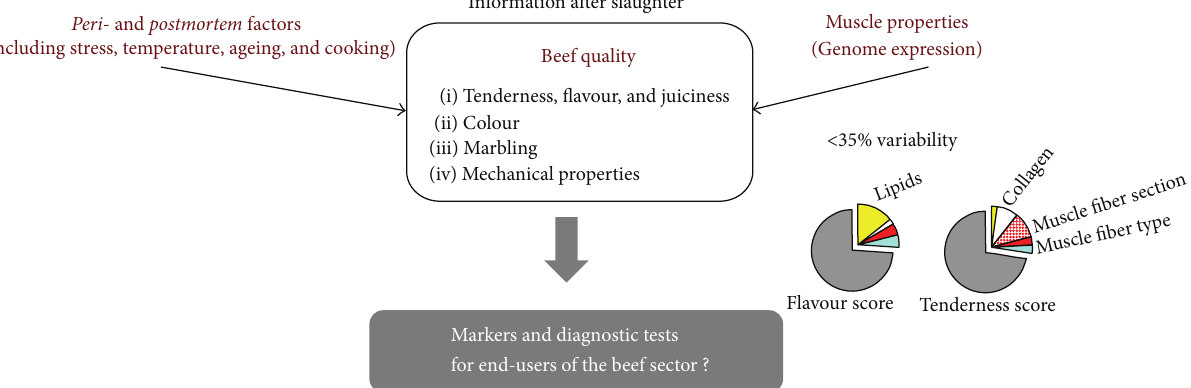
Figure 1: Beef sensory quality. A complex phenotypic trait that is expressed postmortem . A combination of molecular processes in the muscle both in the live animal and during the peri - and postmortem period (stress, interaction of the whole carcass, and muscle characteristics with cooler temperatures affecting rates and extents of postmortem pH decline, ageing, and cooking) contributes to development of beef quality. In particular, the muscle characteristics of the live animals play an important role. However, less than one-third to a fourth of the variability in beef tenderness and flavour can be explained by variability in the muscle characteristics of live animals. The beef industry is looking for biological or molecular indicators that would identify live animals with desirable quality attributes, in order to orientate them towards the most accurate production or market system, provided that slaughtering conditions are